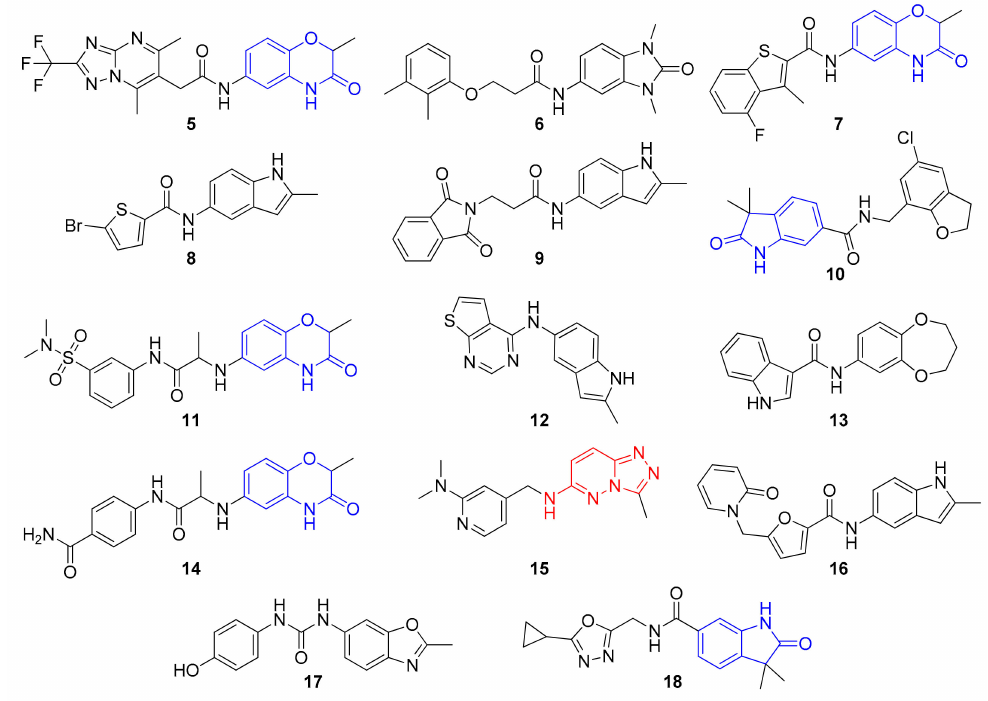
Figure 3. Fourteen compounds from the previous work [15] used as the queries to mine from the REAL Space.